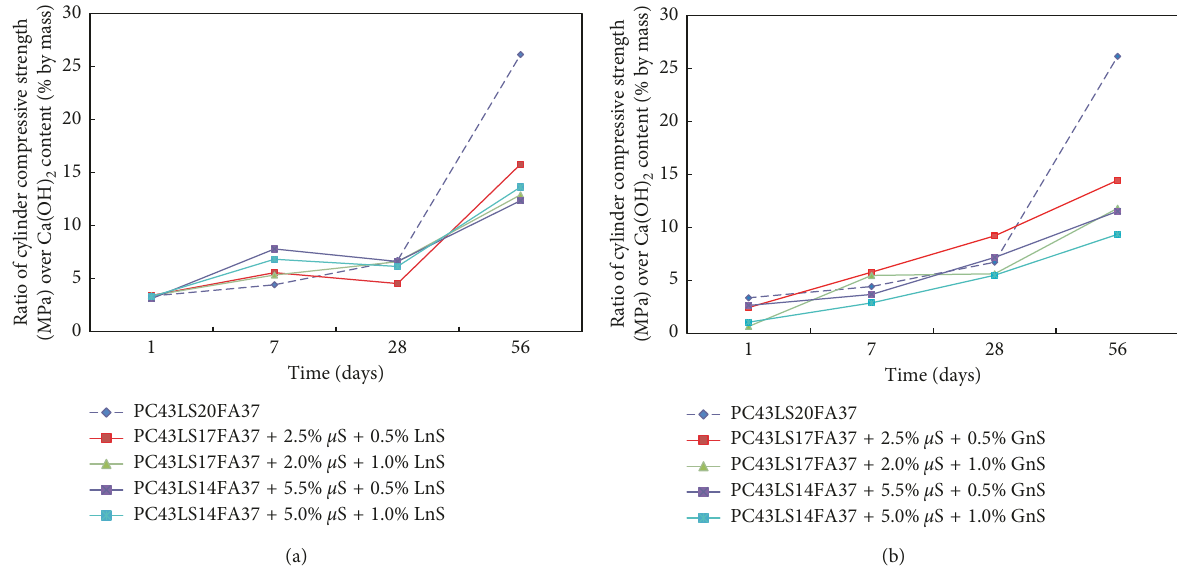
Figure 18: Relating microscale characteristics to macroscale performance of μ S and (a) LnS- or (b) GnS-modified nanocomposite binders based on PC43LS20FA37.